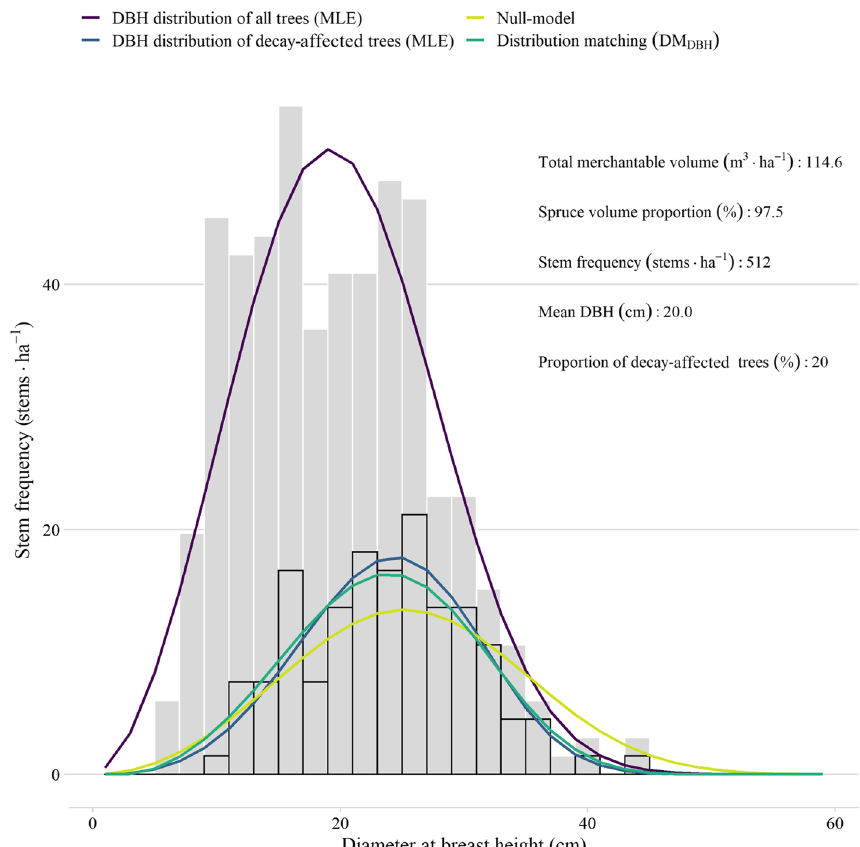
Fig. 6 Example of the harvested segment that produced a small error index ( EI diameter at breast height (DBH) distribution of decay-affected trees. The gray bars show the DBH distribution of all trees, whereas the bars with black borders refer to the DBH distribution of decay-affected trees. Note that density distributions were scaled using observed stem frequencies. MLE, maximum likelihood